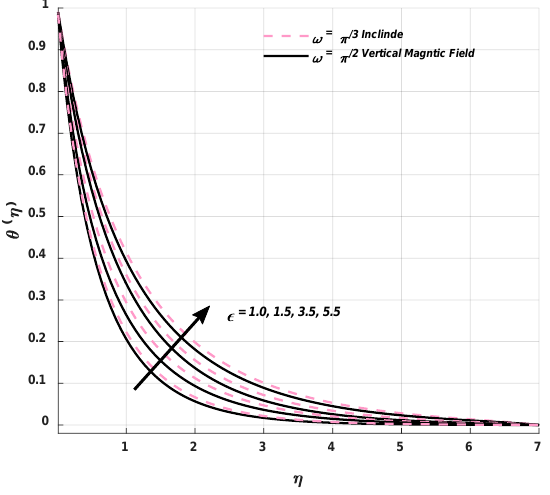
Figure 10. Impact of ε on θ ( η ) .